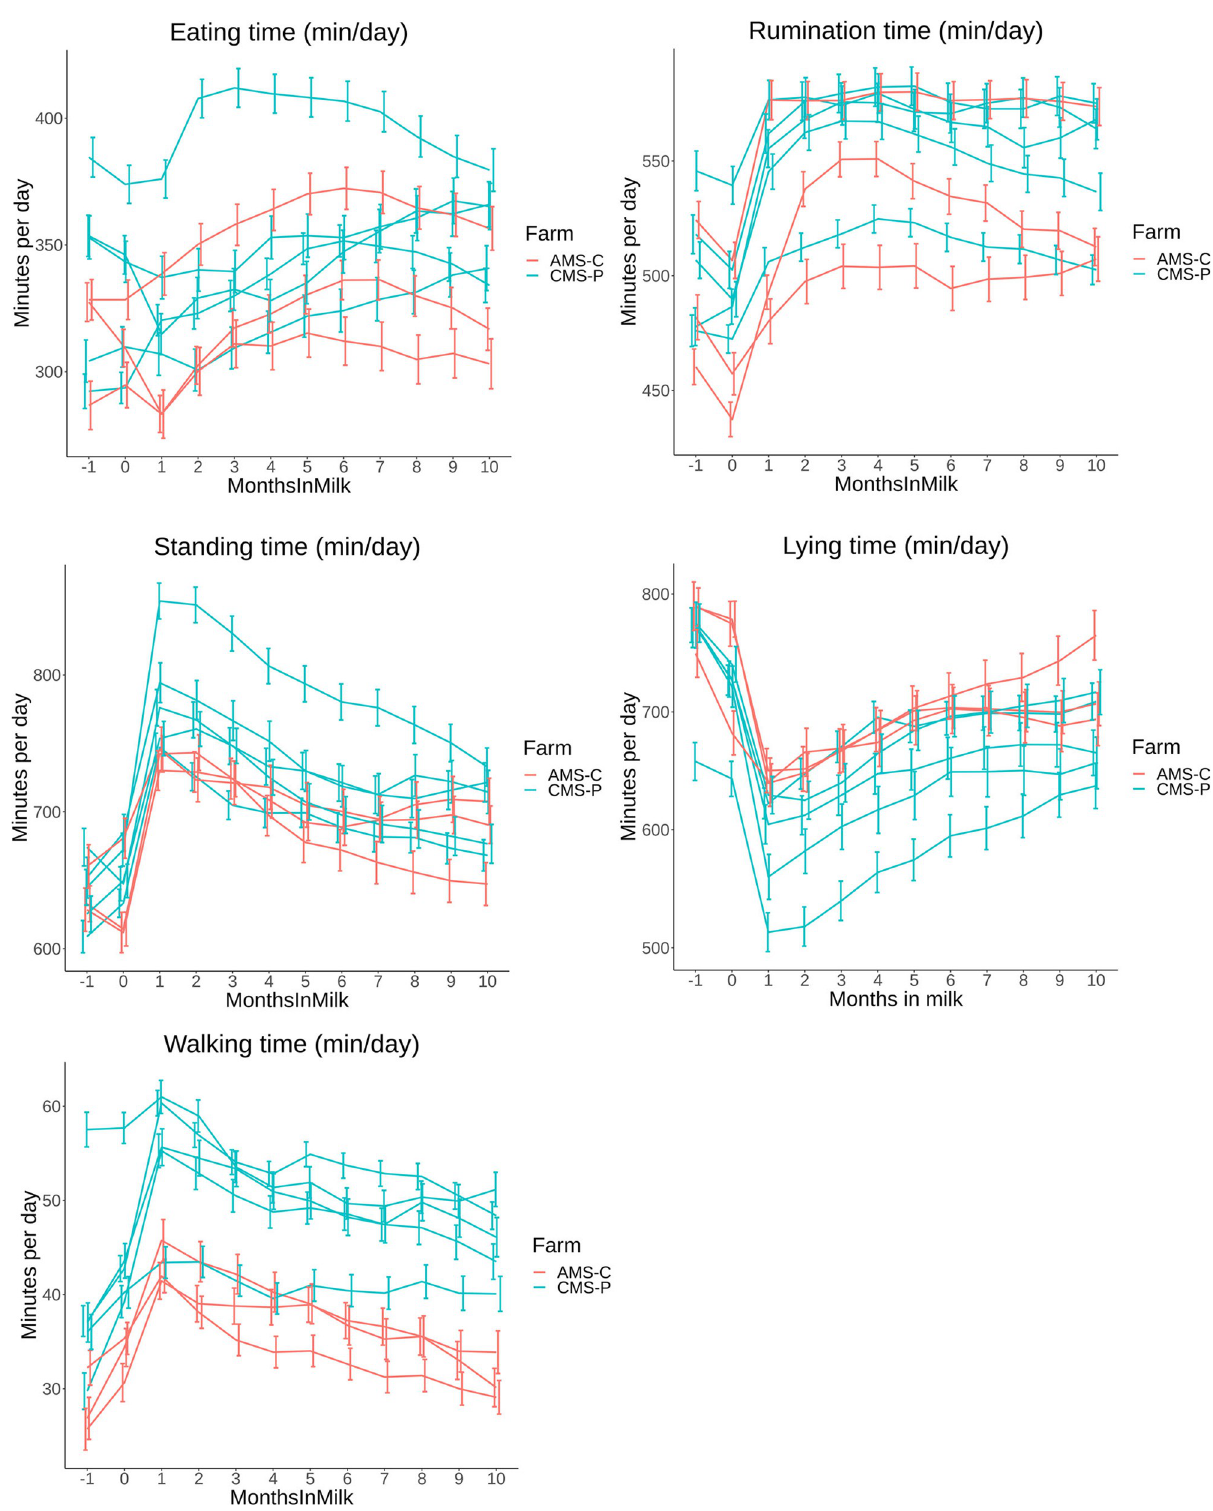
Fig 4. A,B,C,D,E: Time budget parameters in minutes per day (min/day) based on least square means (LSM) with 95% confidence intervals (95% CI) per farm grouped by color: red = AMS-C, blue = CMS-P (automatic milking system–confined, and conventional milking system–pasture access) on